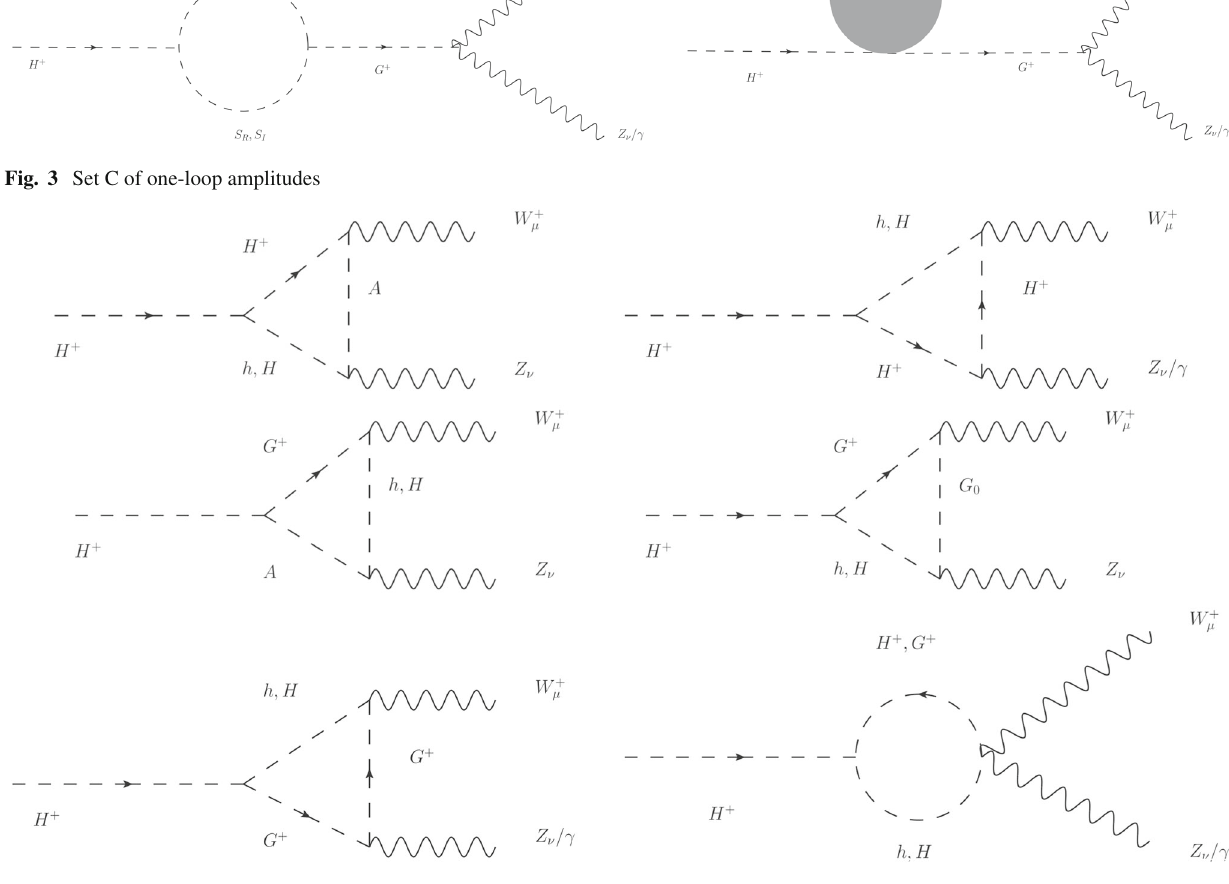
Fig. 4 Set A (cid:5) of one-loop amplitudes for 2HDM